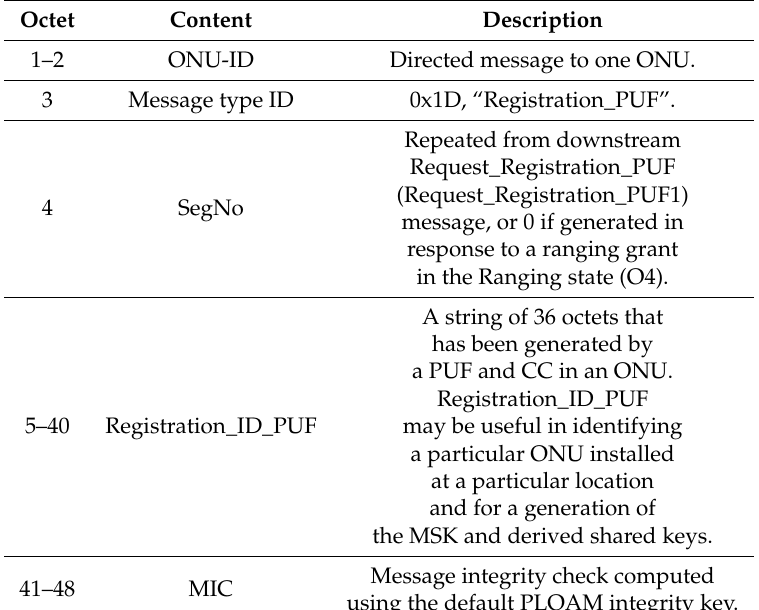
Table 4. Content of Registration_PUF